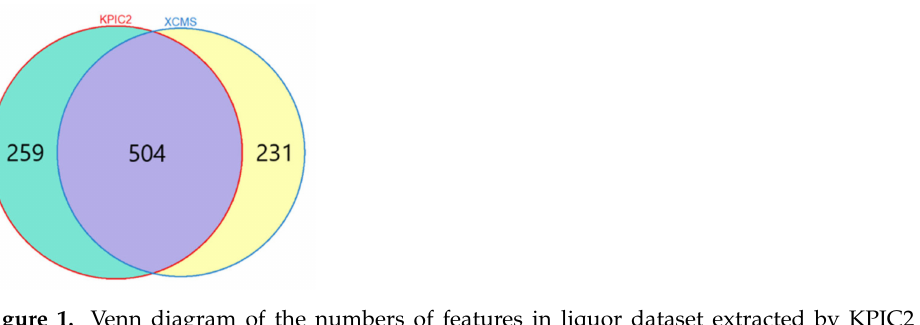
Figure 1. Venn diagram of the numbers of features in liquor dataset extracted by KPIC2 and XCMS. There are 259 features that are unique in KPIC2, and 231 features are also unique in XCMS. There are 504 features that are extracted by both KPIC2 and XCMS, which indicated the reliability of extraction results.